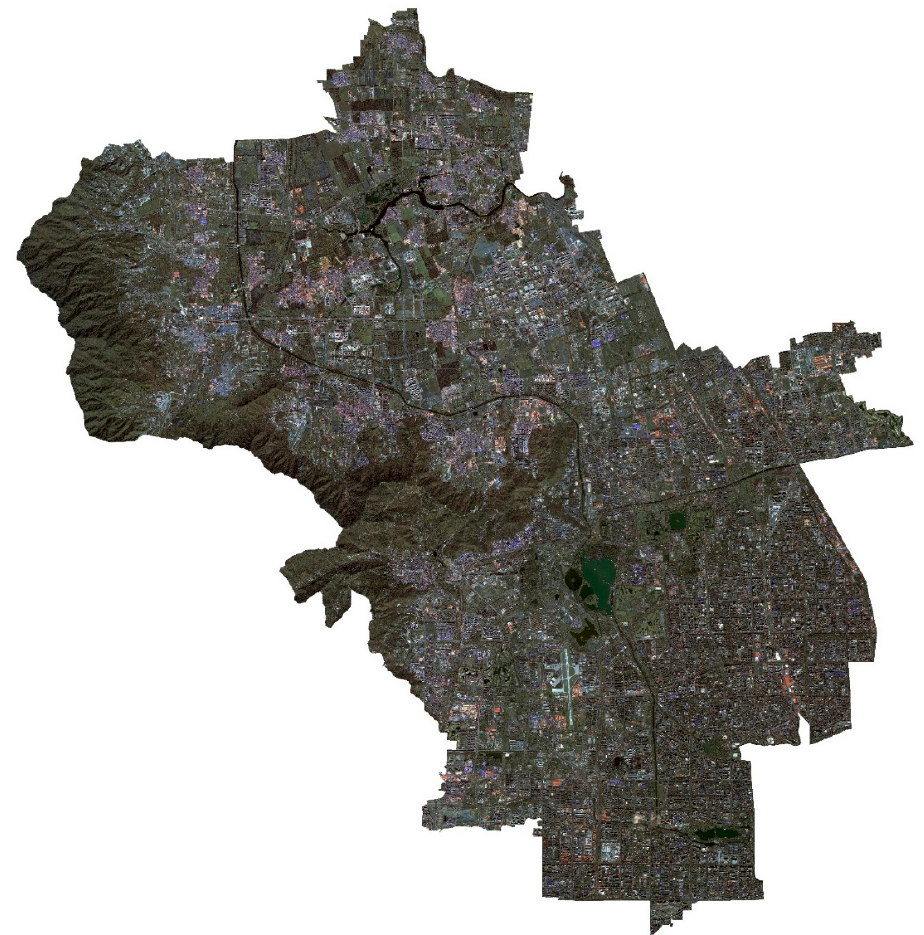
Figure 3. The high-resolution (1.5 m resolution) remote sensing image of Haidian District obtained by the GF-2 satellite.